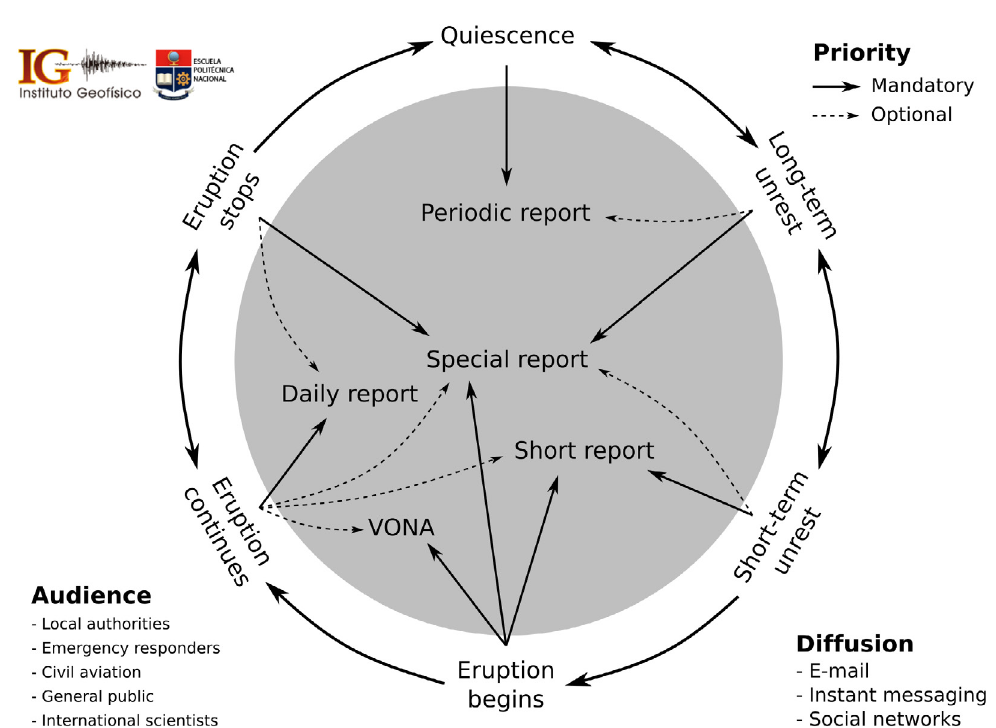
Figure 5: IG-EPN communication plan for Galápagos and Mainland Ecuador based on volcanic status. The arrows connecting the volcanic status can go in both directions for non-eruptive unrest and when eruption stops and resumes. Optional reports depend on the size and evolution of the volcanic